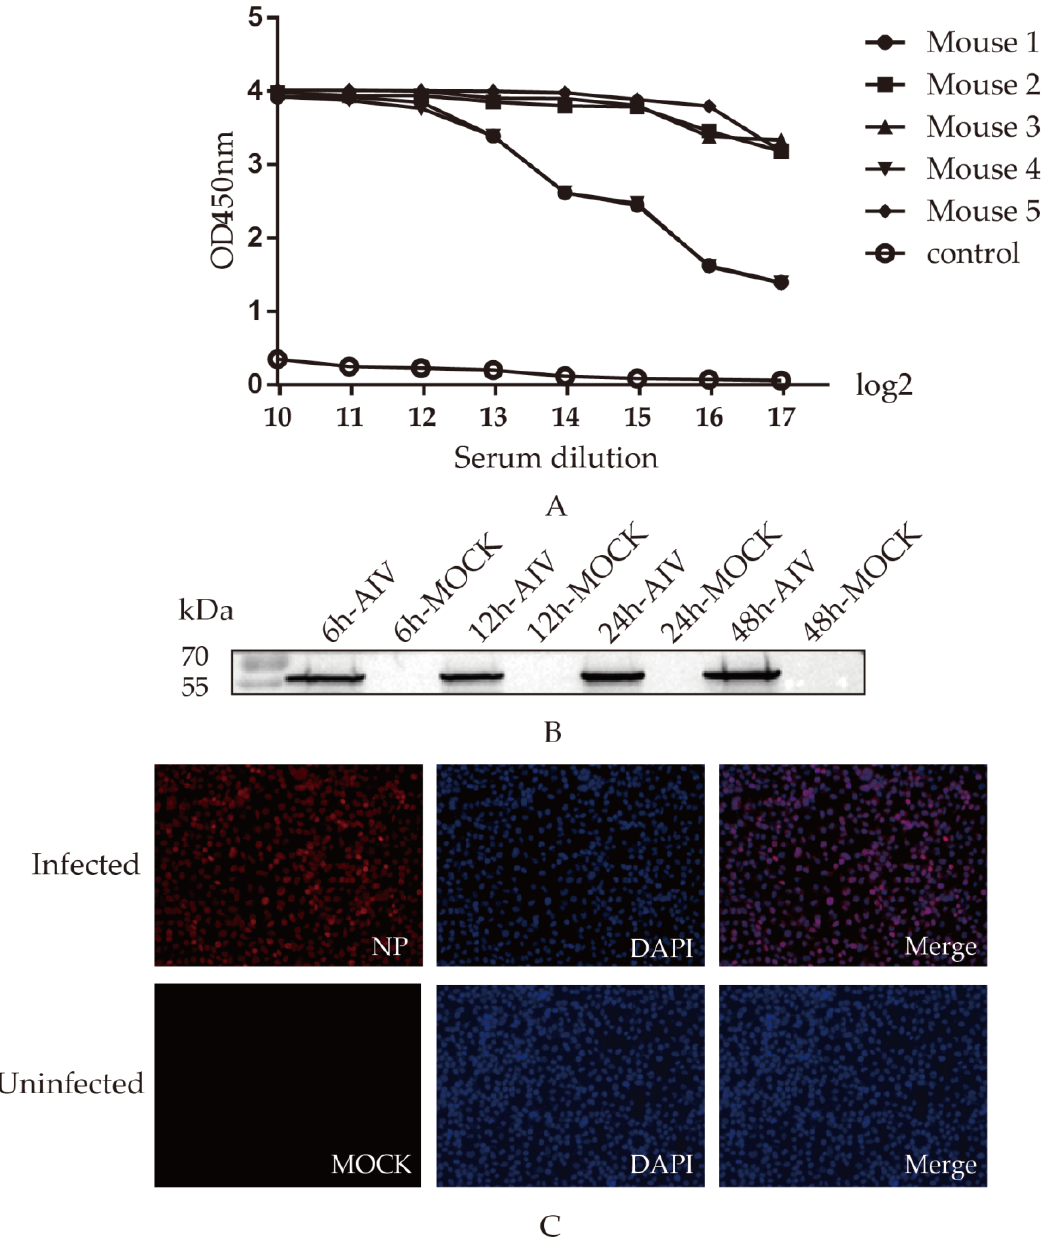
Figure 2. Screening and identification of monoclonal antibodies: ( A ) Antibody levels. Antibody potency in five mice one week after triple immunization. The antibody levels were presented as the absorbance value of OD450nm; ( B ) Relationship between mAb 4F5 and AIV-infected cells. A549 cells were infected with AIV, and the protein samples were collected at 6, 12, 24 and 48 h to detect recognition between NP protein and mAb 4F5 by Western blotting; ( C ) Reactivity of mAb 4F5 detected by indirect immunofluorescence. A549 cells were infected with AIV, and the reactivity of mAb 4F5 with NP protein of AIV was detected with indirect immunofluorescence. The NP protein was marked in red, and the nucleus was marked in